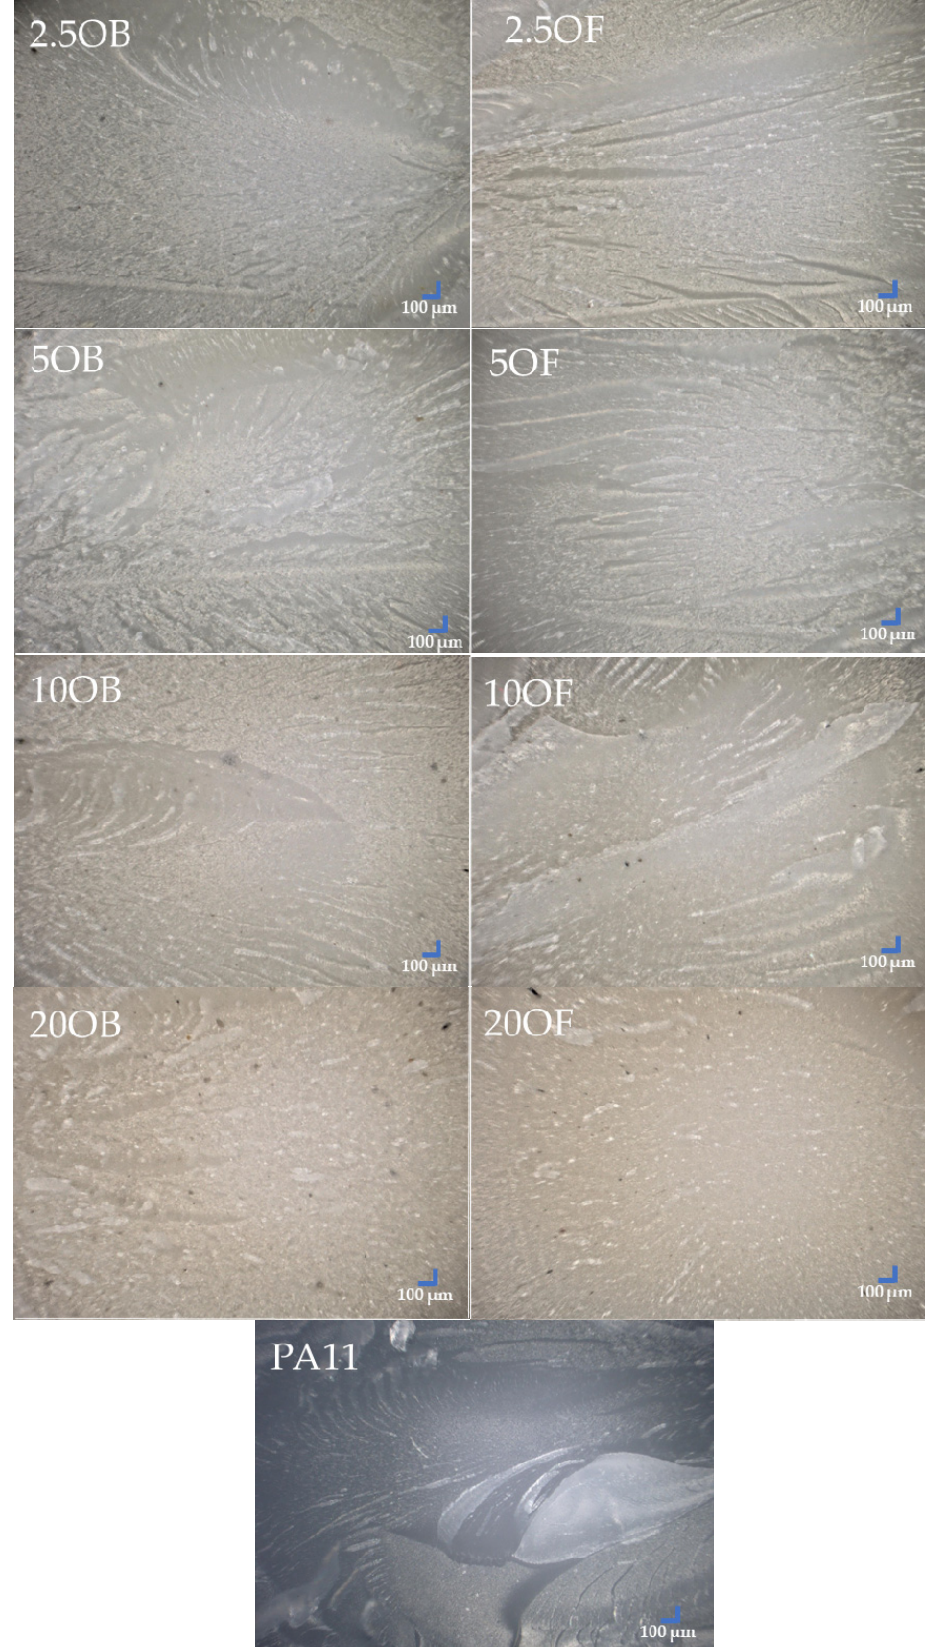
Figure 14. Biocomposite fractures after notched impact strength testing.